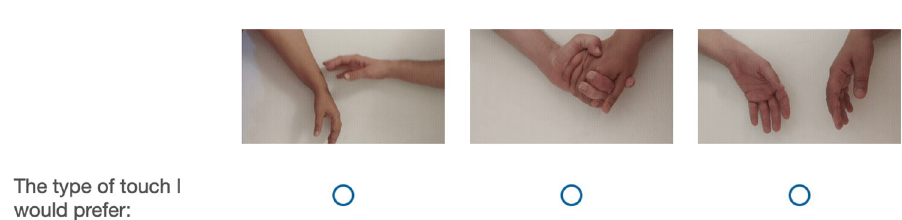
Fig 1. The touch preference screen shown to participants. The types of touch depicted are, from left to right, stroking, handholding, and no touch. The types of touch were depicted with videos, so the figure shows a still image from each video. Touch type order was